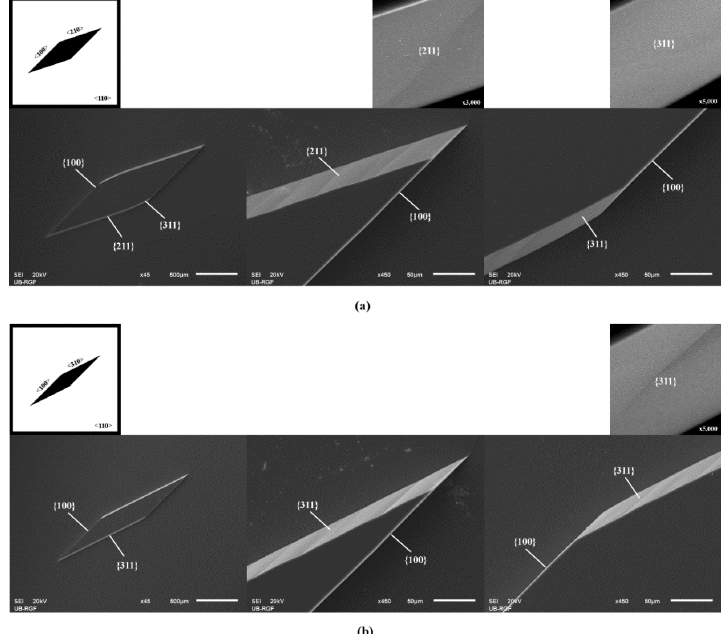
Table 1. The values of acute and obtuse angles of the parallelograms.